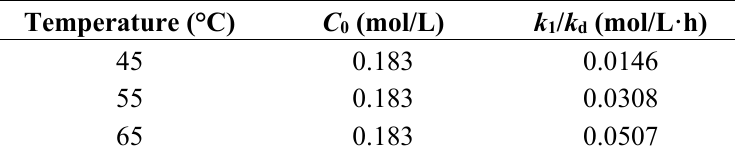
Figure 3. Kinetic modeling of the sulfonation reaction: ( a ) linearization of the kinetic expression as a function of time, ( b ) comparison between the experimental data and the model prediction ( R 2 = 0.98 for the data at 45 °C, R 2 = 0.97 for the data at 55 °C, R 2 = 0.99 for the data at 65 °C). Table 1. k 1 / k d ratio obtained at different